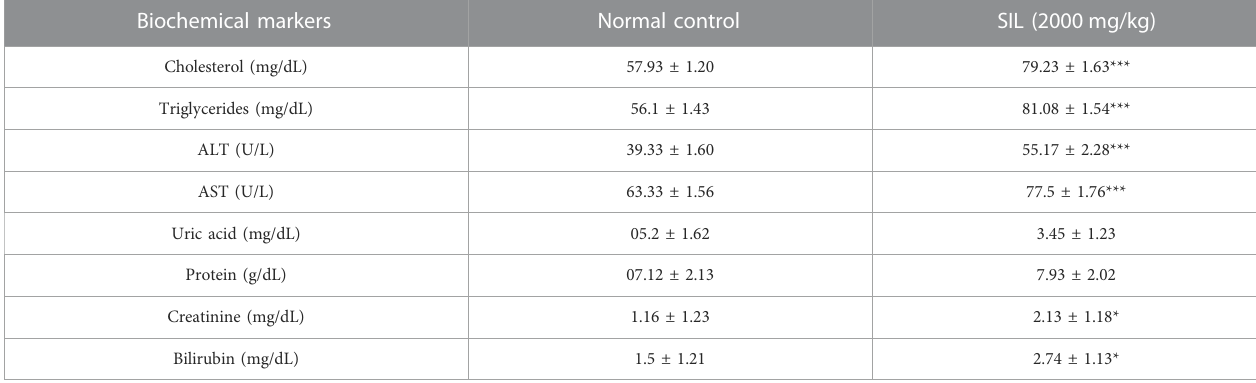
TABLE 4 Estimation of biochemical markers in acute oral